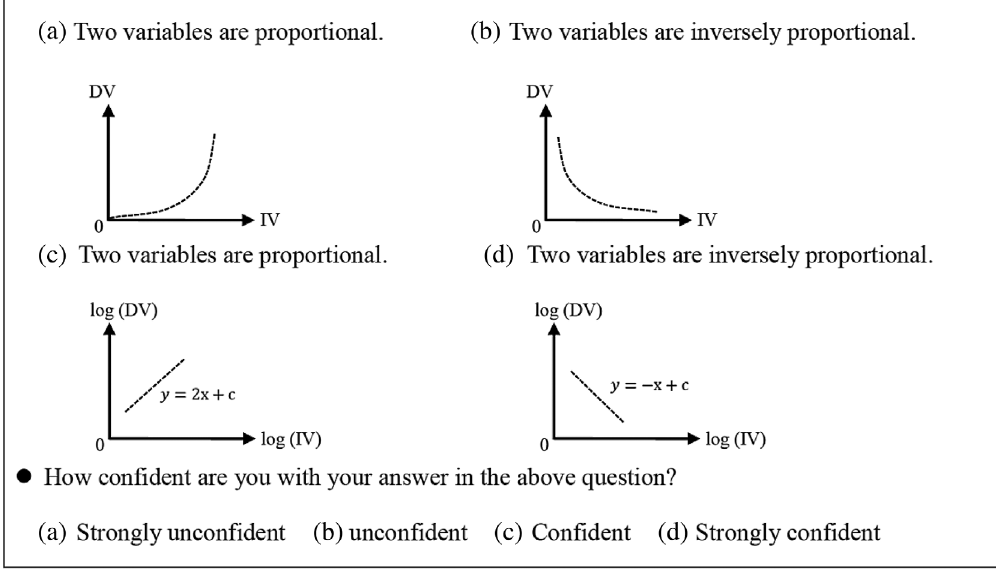
FIG. 2. An example question of the Integrated Science Process Skills Test and the related confidence